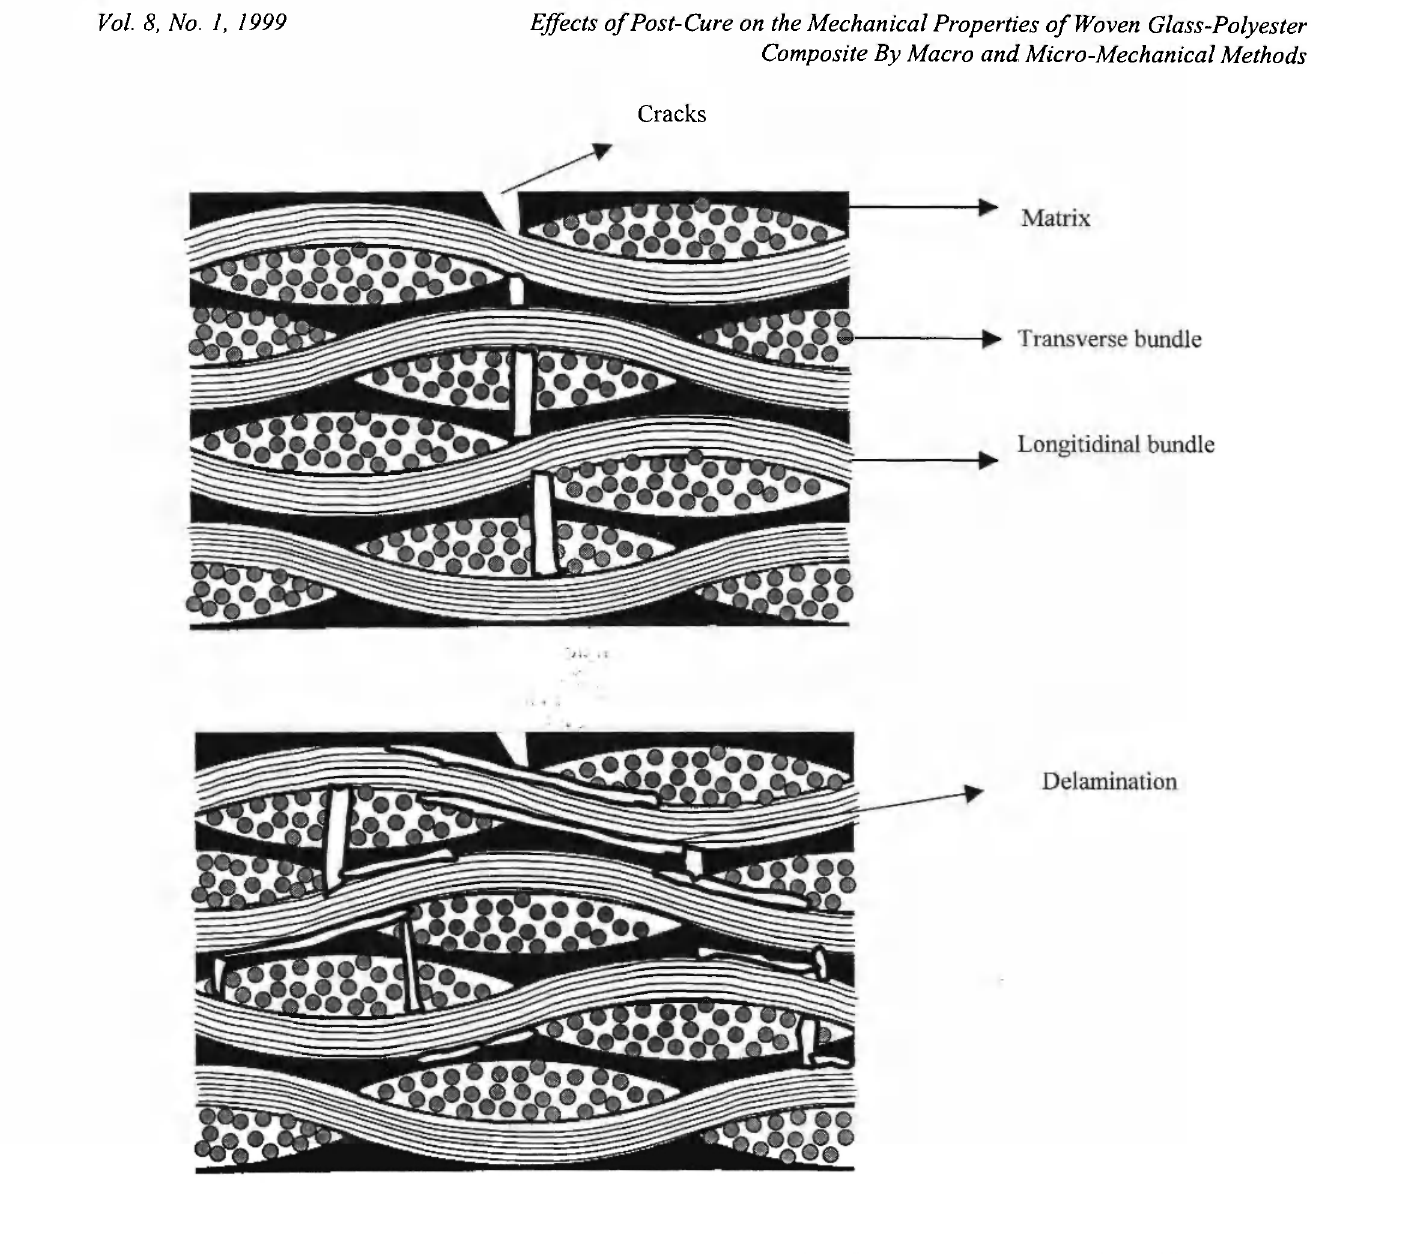
Fig. 5a-b: Schematic of two contrasting situations: (a)-A resistance interface (post cured composite), (b) lower shear resistance interface (composite without